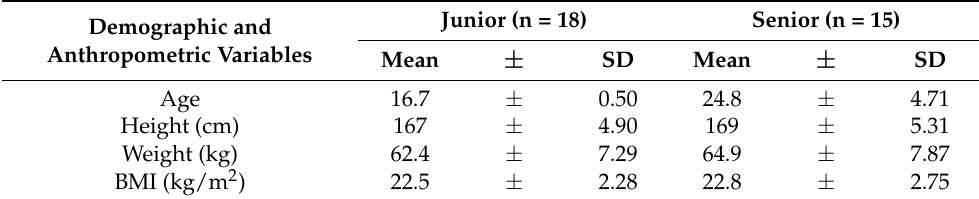
Table 1. Demographic and basic anthropometric characteristics of professional female beach hand- ball players.